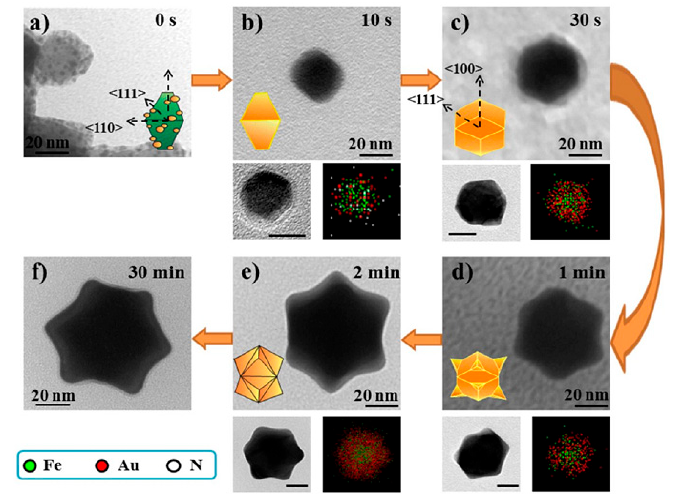
Figure 10. TEM images of Fe 3 O 4 -Au NPs and their elemental analysis (spot-mapping) for different reaction times: ( a ) 0; ( b ) 10 s; ( c ) 30 s; ( d ) 1 min; ( e ) 2 min; and ( f ) 30 min. Iron appears in green, gold in red and nitrogen in white. Reproduced with permission from [65]. American Chemical Society, 2014.